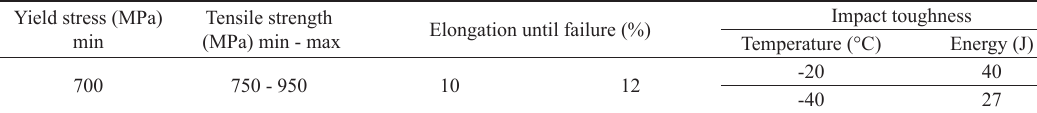
Table 2. Mechanical properties of Domex 700 MC steel.